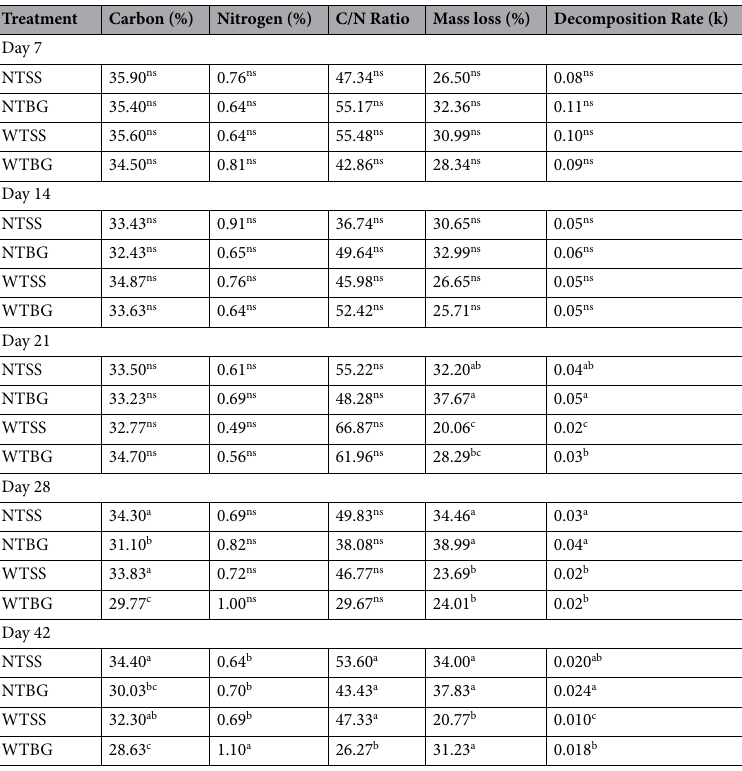
Table 3. Decomposition parameters observed in litterbags. *Means with the same letter are not significantly different ( p < 0.05). NTSS = no Trichoderma on soil surface; NTBG = no Trichoderma below ground; WTSS = with Trichoderma on soil surface; WTBG = with Trichoderma below